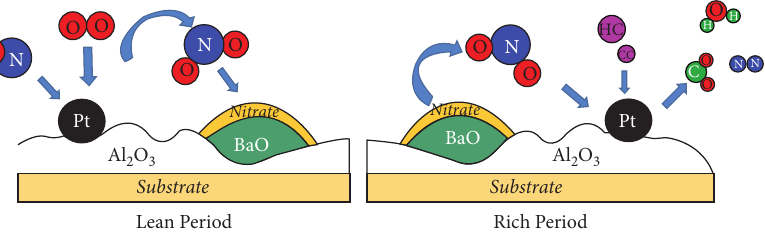
Figure 1: Working of a lean NOx trap.